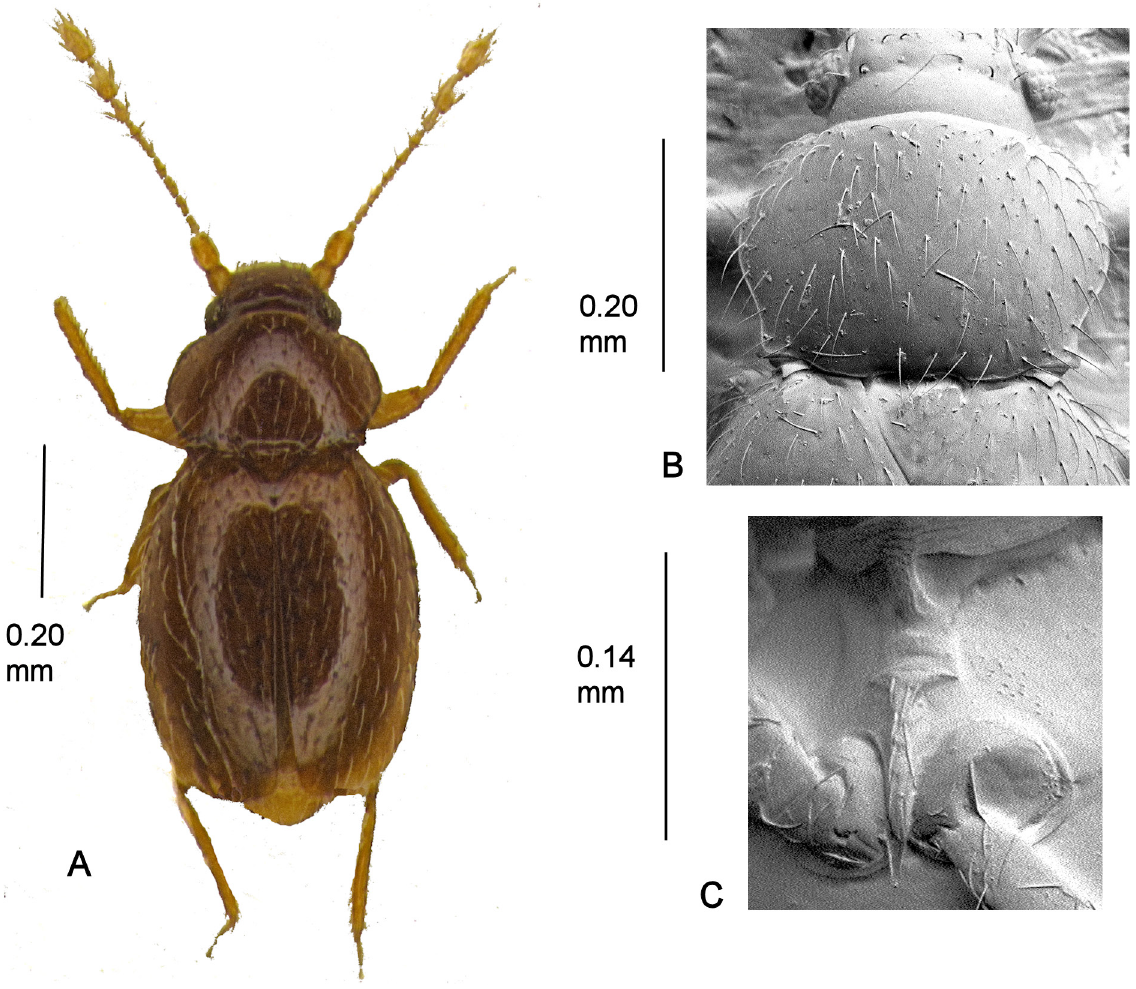
Fig. 70. Cissidium faustum sp. nov. A . Habitus. B . Pronotum, × 695. C . Mesoventrite showing median process of collar, mid-keel and keel, ×